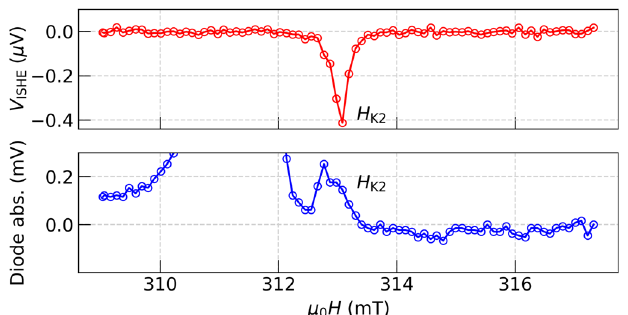
FIG. 8. Comparison of H diode